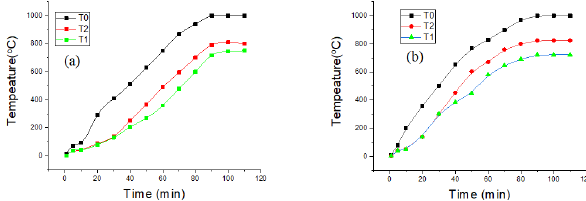
Figure 14: Diagram of temperature as a function for coated samples piston substrate (a) 500 µ m and (b) 1000 µ